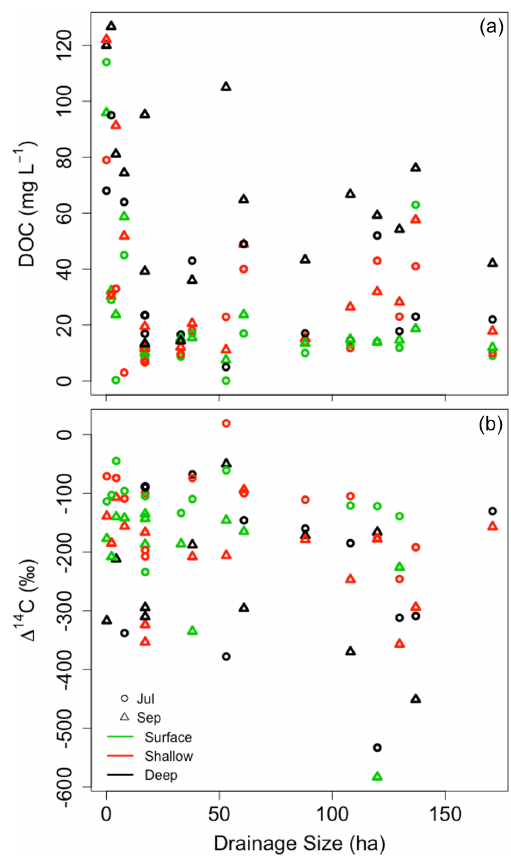
Figure 5. DOC concentration (a) and DOC 14 C (b) versus drainage size.